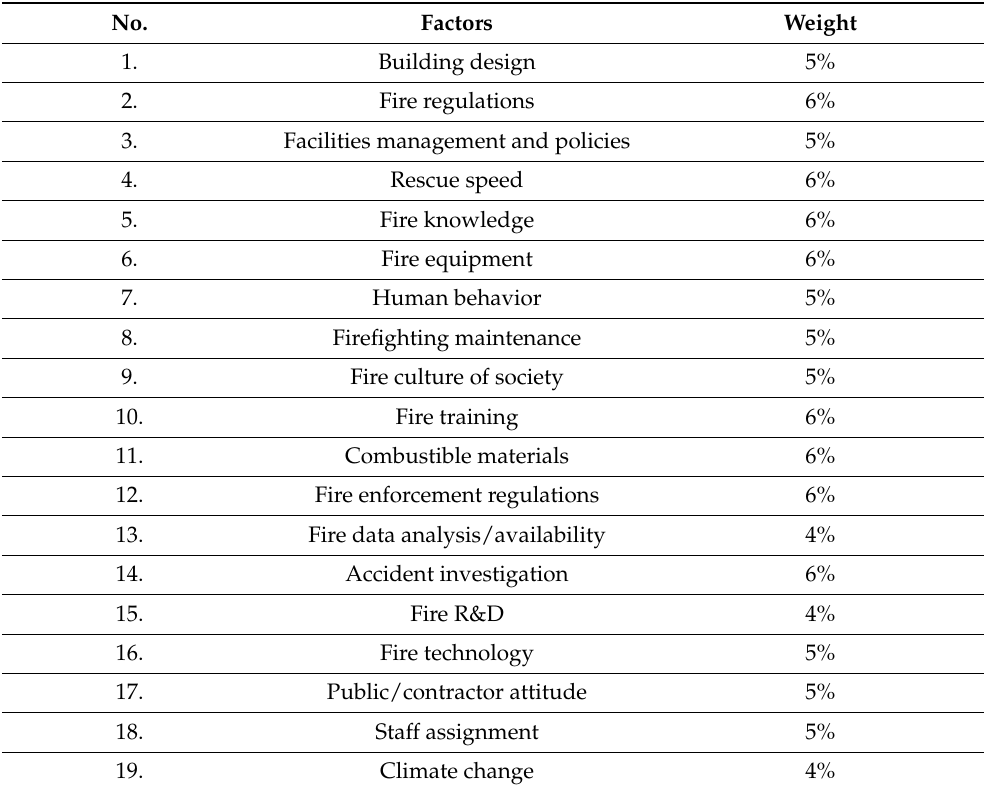
Table 2. Factors effecting fire management system in the residential